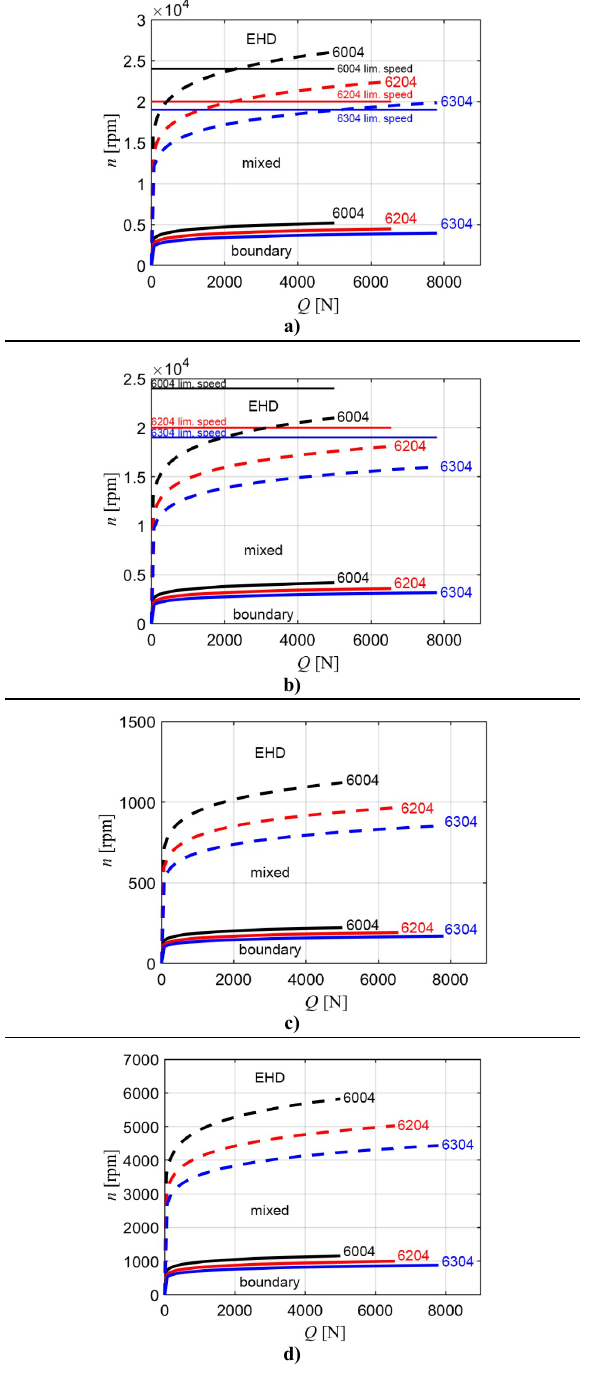
Figure 6. A plot that shows a lubrication regime dependence of the number of revolutions n and external radial load Q for particular rolling bearings and balls-inner raceway contact, with contact surfaces roughness of R ar =0.14 μ m and R ab =0.05 μ m, operating temperature of 38°C and oil lubricant: a) Advanced Ester, b) Polyalkyl Aromatic, c) Synthetic Paraffinic Oil (Lot 4), d) Super- Refined Naphthenic Mineral Oil